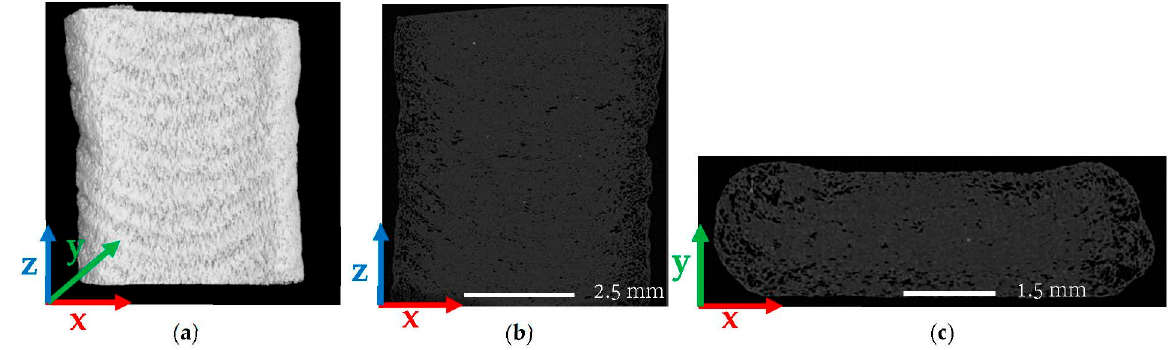
Figure 8. µCT images of a SCF/ABS roller-compressed bead: ( a ) 3D view; ( b ) 2D front view; ( c ) 2D.